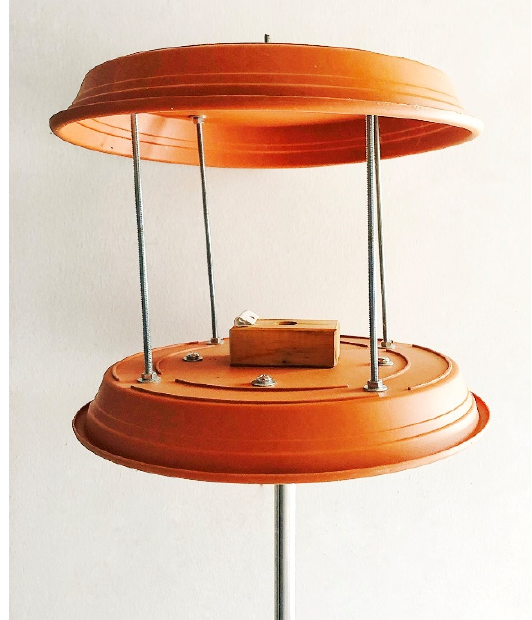
Figure 2. Self-constructed gravimetric pollen trap used for this study.